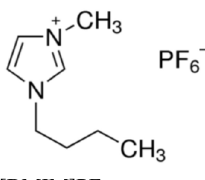
Fig. 1 Structure of [BMIM]PF 6